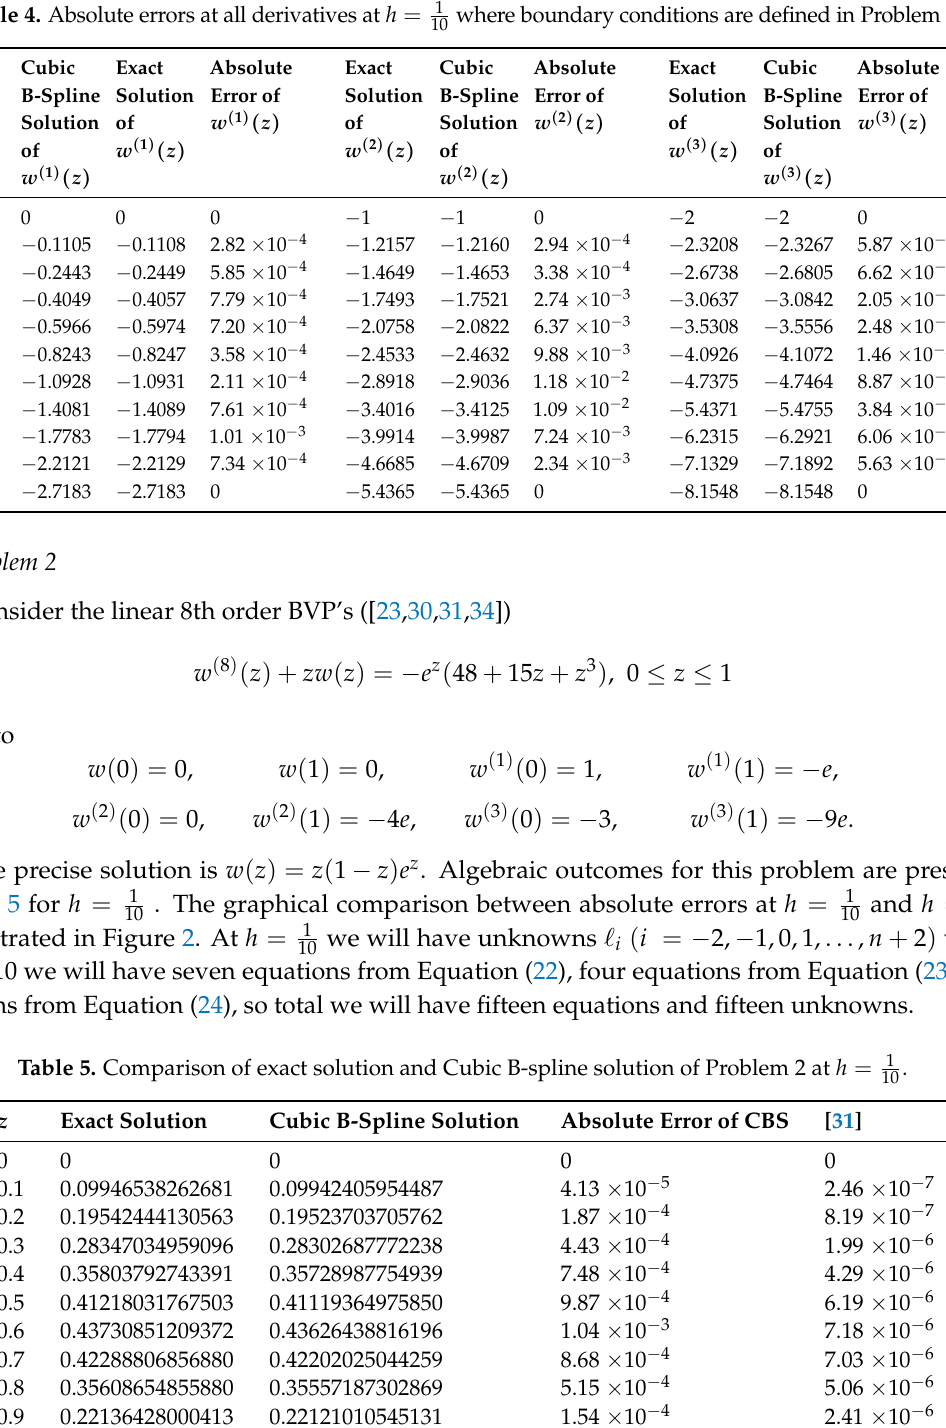
Table 4. Absolute errors at all derivatives at h = 1